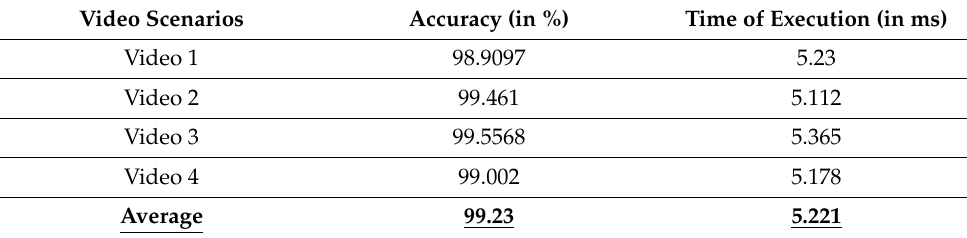
Table 5. Performance of the RTDE